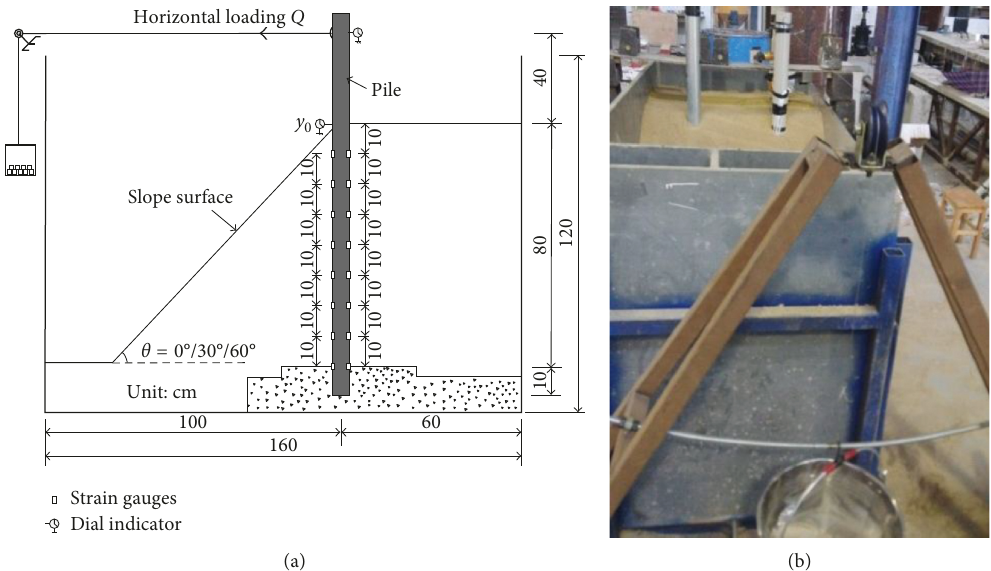
Figure 7: Layout of model tests: (a) profile of the model tests; (b) loading frame.